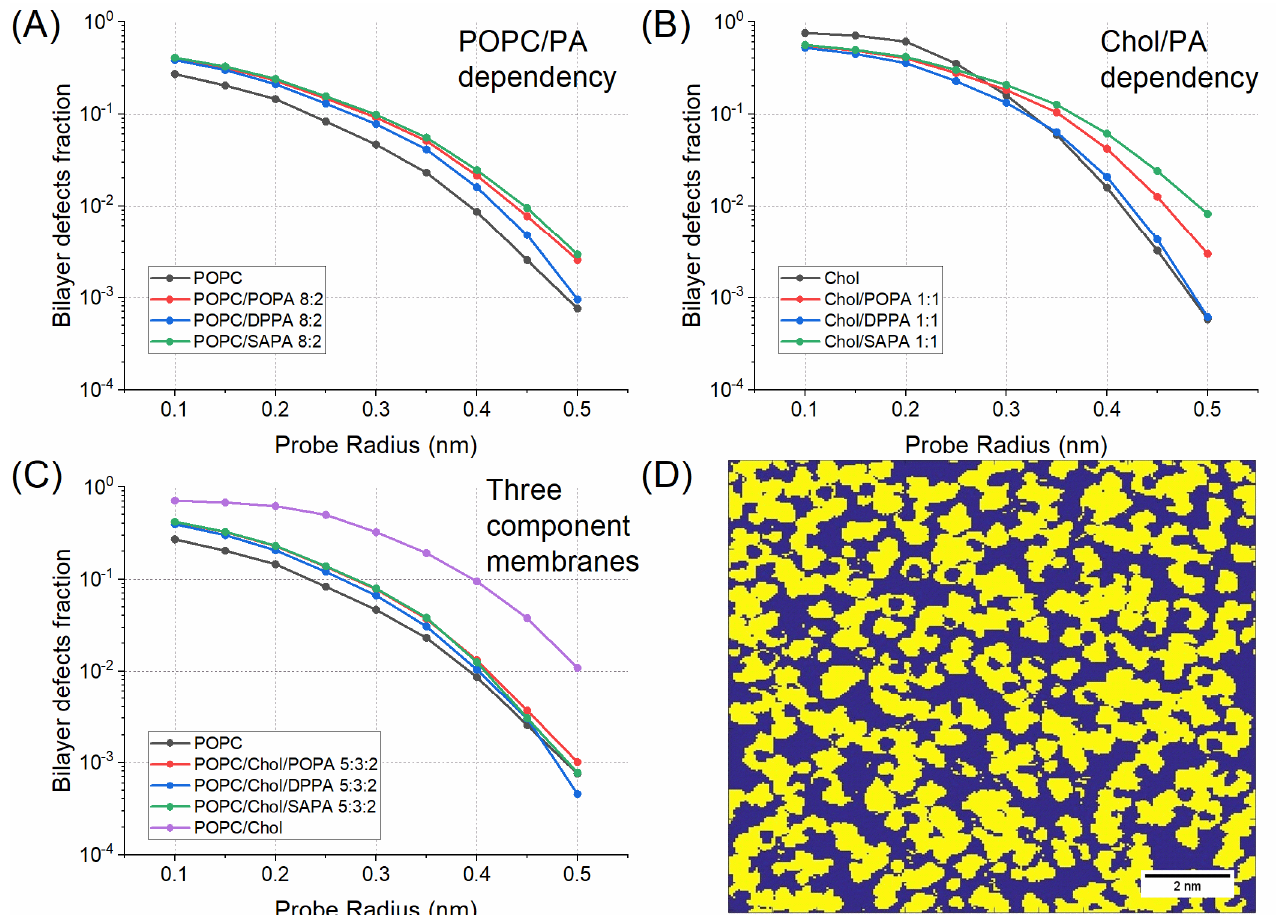
Figure 2. Fraction of exposed acyl chains in function of probe radius for ( A ) POPC/PA, ( B ) Chol/PA, and ( C ) POPC/Chol/PA membrane systems. ( D ) A top-down probed surface grid of a frame in the POPC/SAPA bilayer simulation. On the grid, yellow represents the headgroup region, while blue represents the acyl chains region. The surface is probed with 0.2 nm radius size.